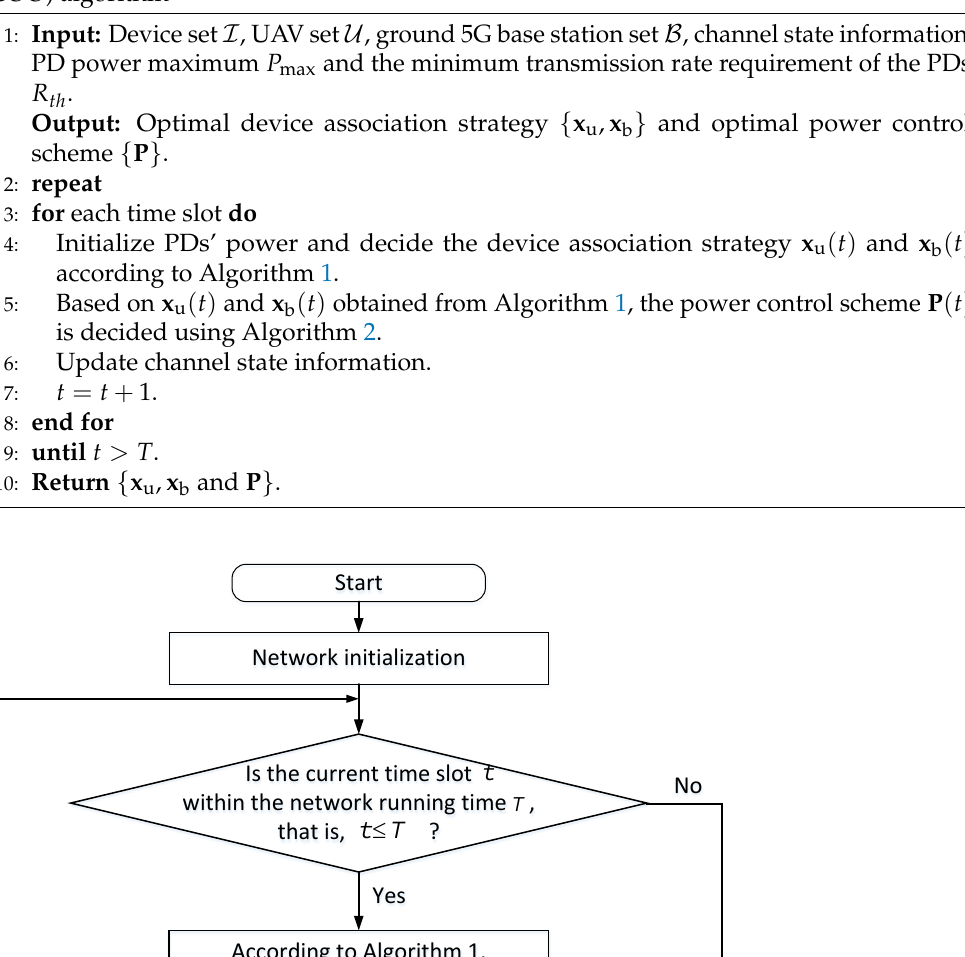
Algorithm 3 : Joint Device Association and Power Control Online Optimization (JDAP- COO) algorithm